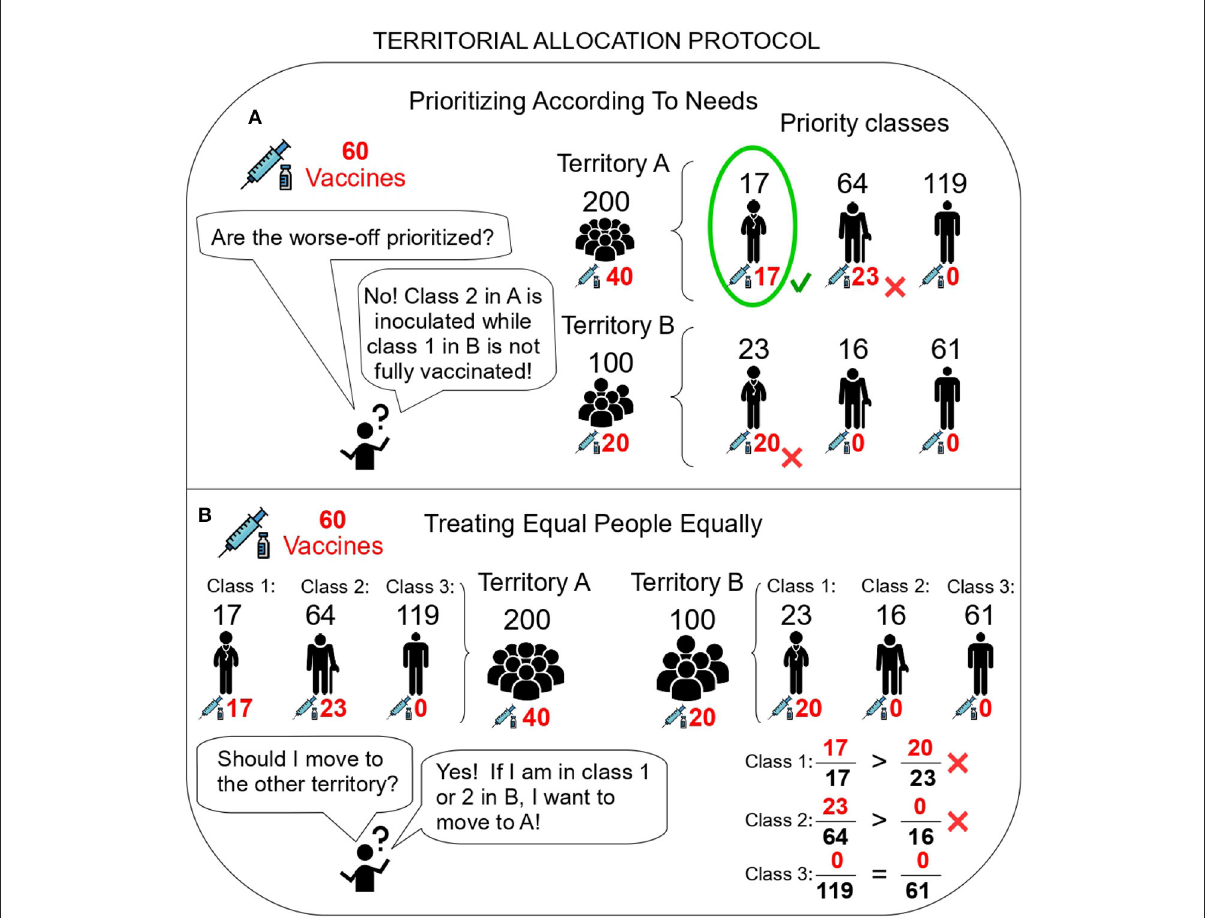
FIGURE3 The Territorial Allocation protocol violates ethical principles. (A) The Territorial Allocation protocol violates Prioritizing According To Needs . Territory A receives two thirds of the vaccinations (40), which suffice to fully immunize the first class and partially inoculate the second ( R 1 A = 17, R 2 A = 23 > 0). Territory B receives one third of the vaccinations (20), which is insufficient to fully immunize the first class ( R 1 B = 20 < 23). (B) The Territorial Allocation protocol violates Treating Equal People Equally . For the first and second priority classes, vaccination rates are worse in territory B than in territory A , and hence B -residents belonging to those classes would prefer to move to A . Icons made by Freepik from Flaticon